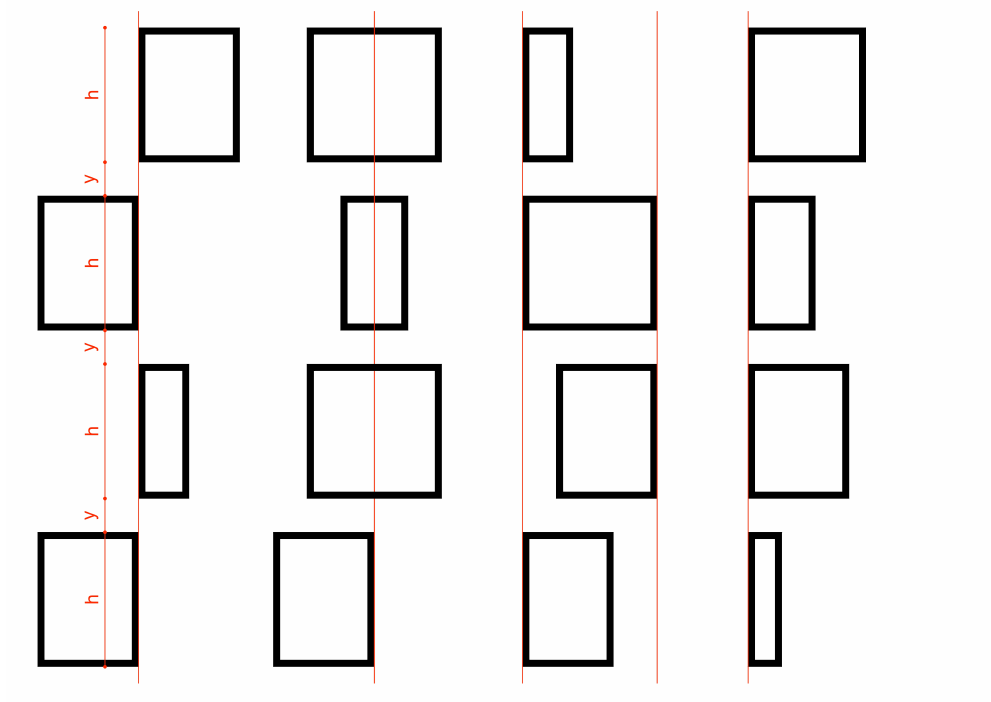
Figure 6. Diagram showing the assumptions of a “Z”